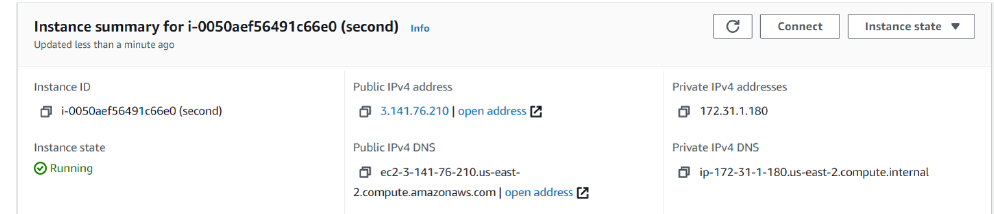
Figure 4. Experiment 2: AWS instance public and private IP addresses.